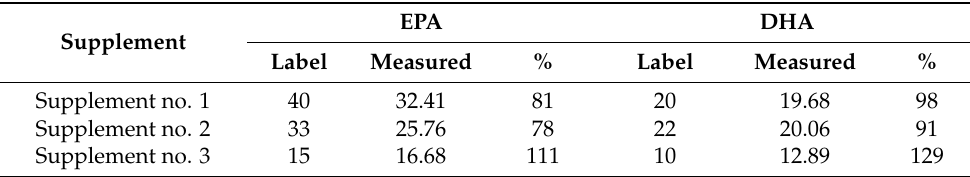
Table 2. Compliance with the label of dietary supplements analyzed (mg/100 mg oil).